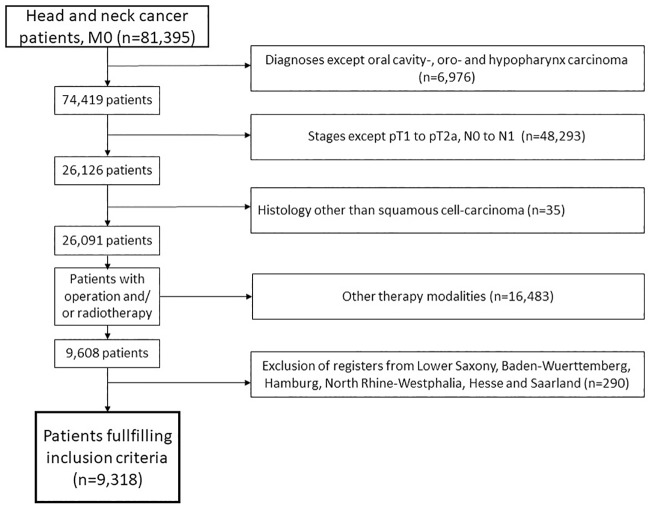
Quorum flowchart of the reasons for non-participation.The GCCR register contained, at the time of the query, 81,395 non-metastasised head and neck cancer patients.